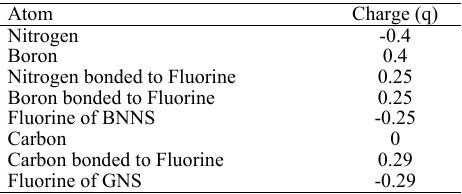
Table 1: Partial charges of GNS and BNNS atoms obtained from DFT calculations. Table1. Partial charges of GNS and BNNS atoms obtained from DFT calculations.